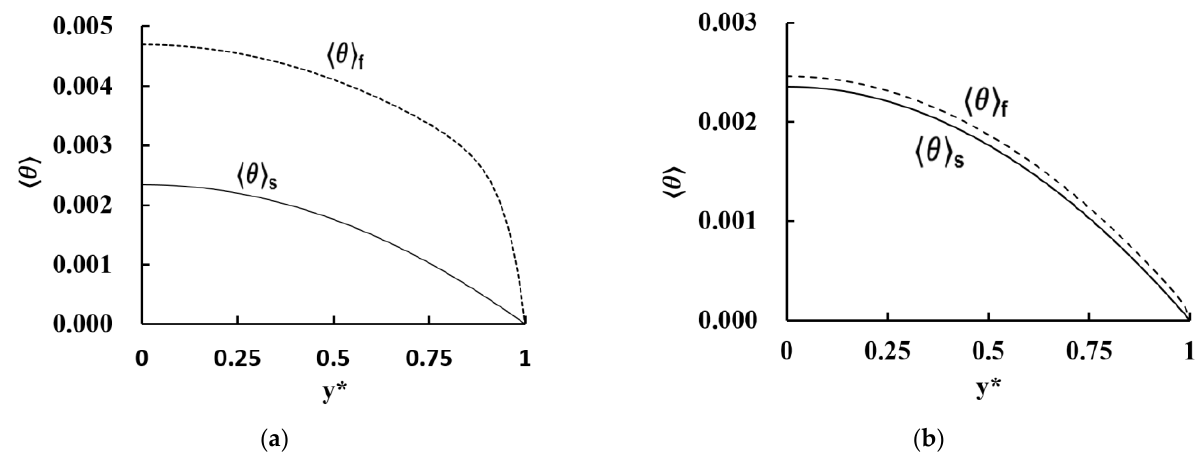
to Re 𝐻 = 10. For 5 PPI channel, the values of interfacial Nusselt number and thermal dis-